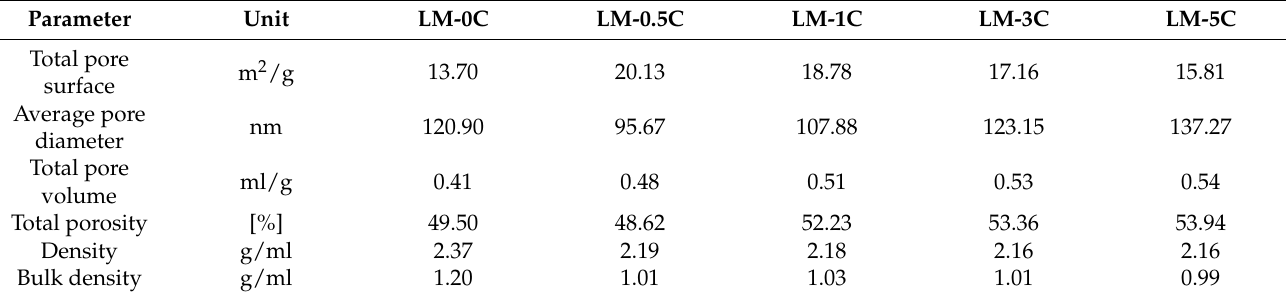
Table 3. The average results of the paste tests performed by means of mercury porosimetry.